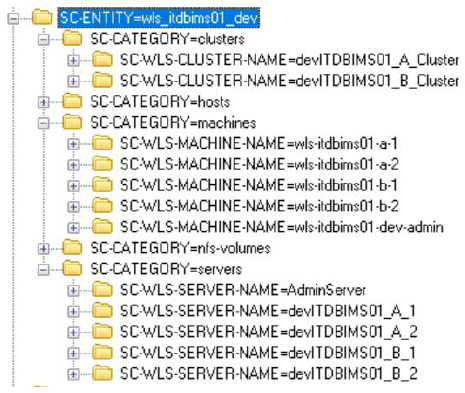
Table 1. URLs served by the team.